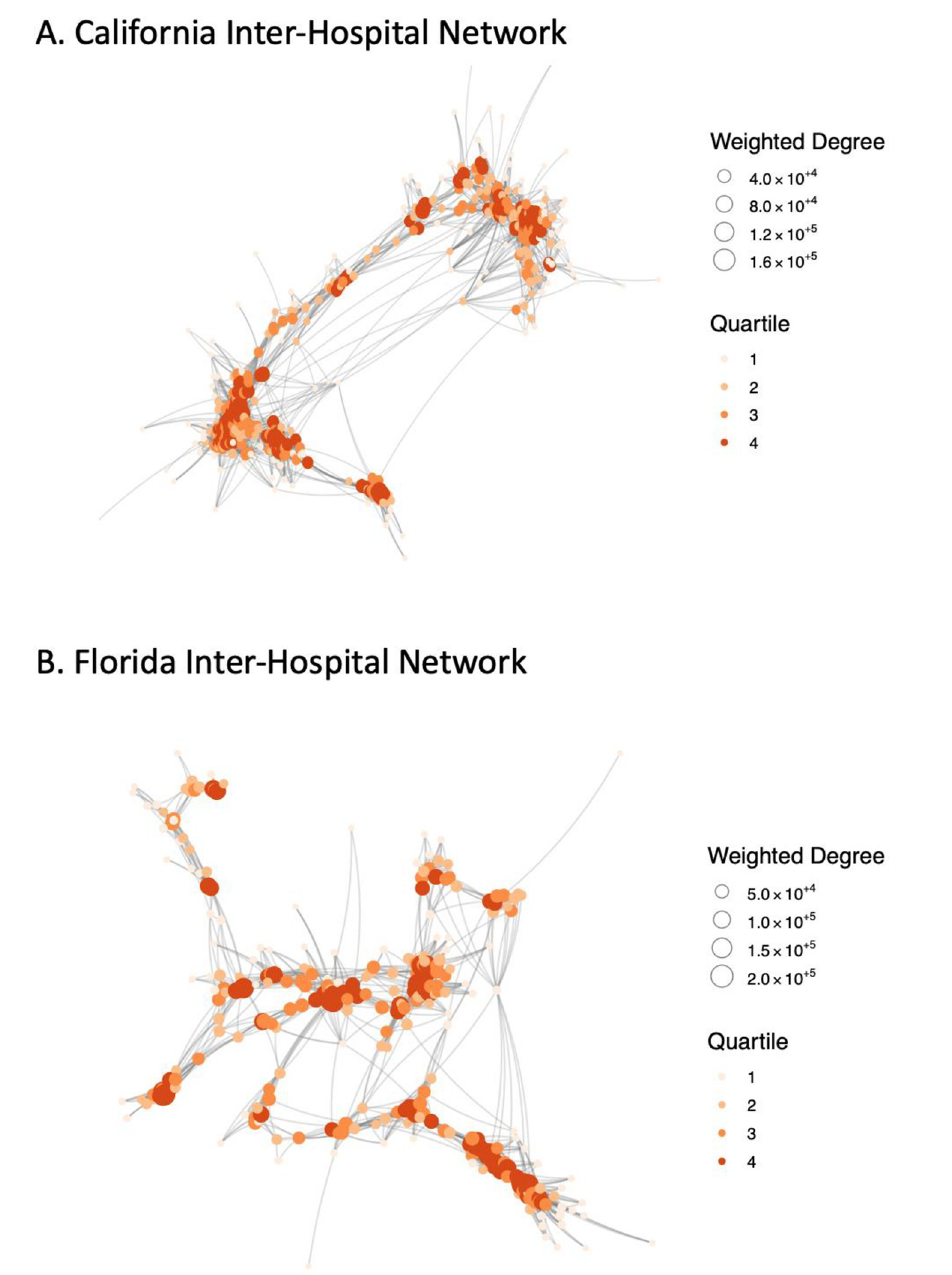
Fig 2. Inter–hospital networks in A) California 2011 and B) Florida 2014, where each node represents one hospital, and the links represents shared patients. Hospital node size represents the hospital’s weighted degree, where larger nodes have higher degrees and are more central in the network. Hospital node color represents the hospital’s centrality quartile, where the dark red nodes (quartile 4) are most central. Hospitals are clustered according to how many patients they